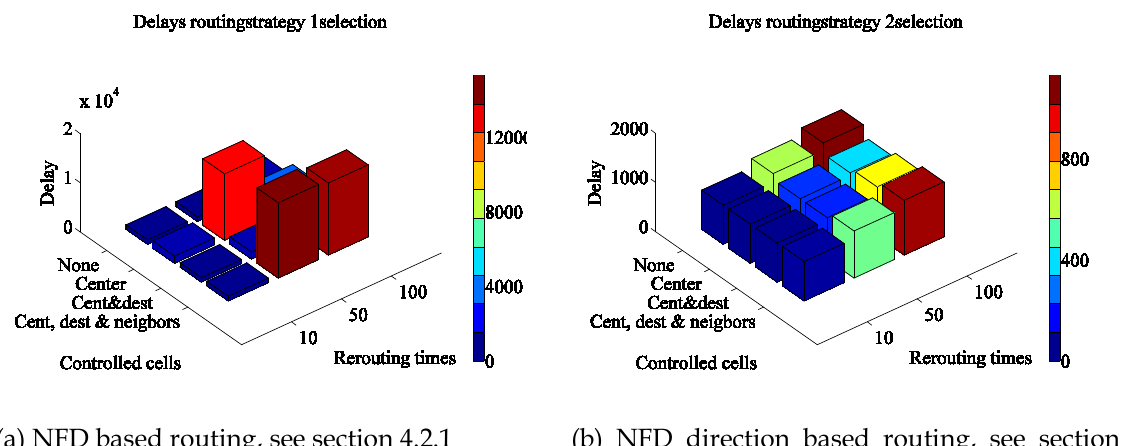
Figure 6. The delays for different routing strategies. Note the scale for the z-axis and colour is different for both